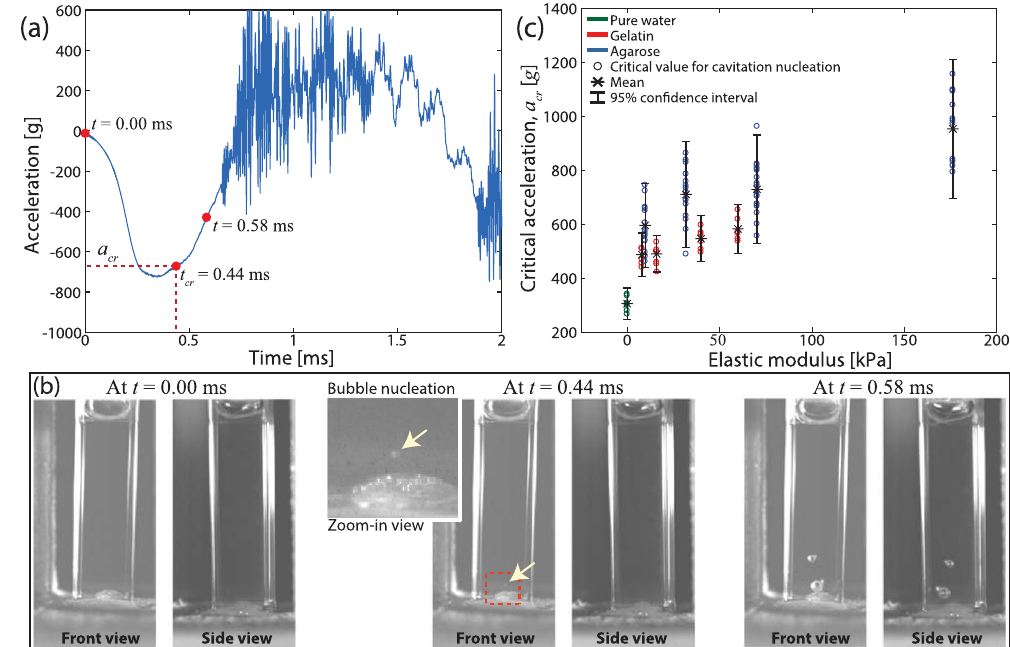
Figure 3. The critical acceleration ( a cr ) for the onset of cavitation nucleation in soft samples. ( a ) Acceleration signal for a 0.3% agarose sample during impact and (b ) the corresponding high speed camera images at three different time points: (left to right) initial configuration, cavitation nucleation, and the maximum radii of bubbles. ( c ) shows a cr as a function of the estimated elastic modulus of soft material samples. The critical acceleration of agarose is directly compared with pure water (green) and gelatin (red) samples 15